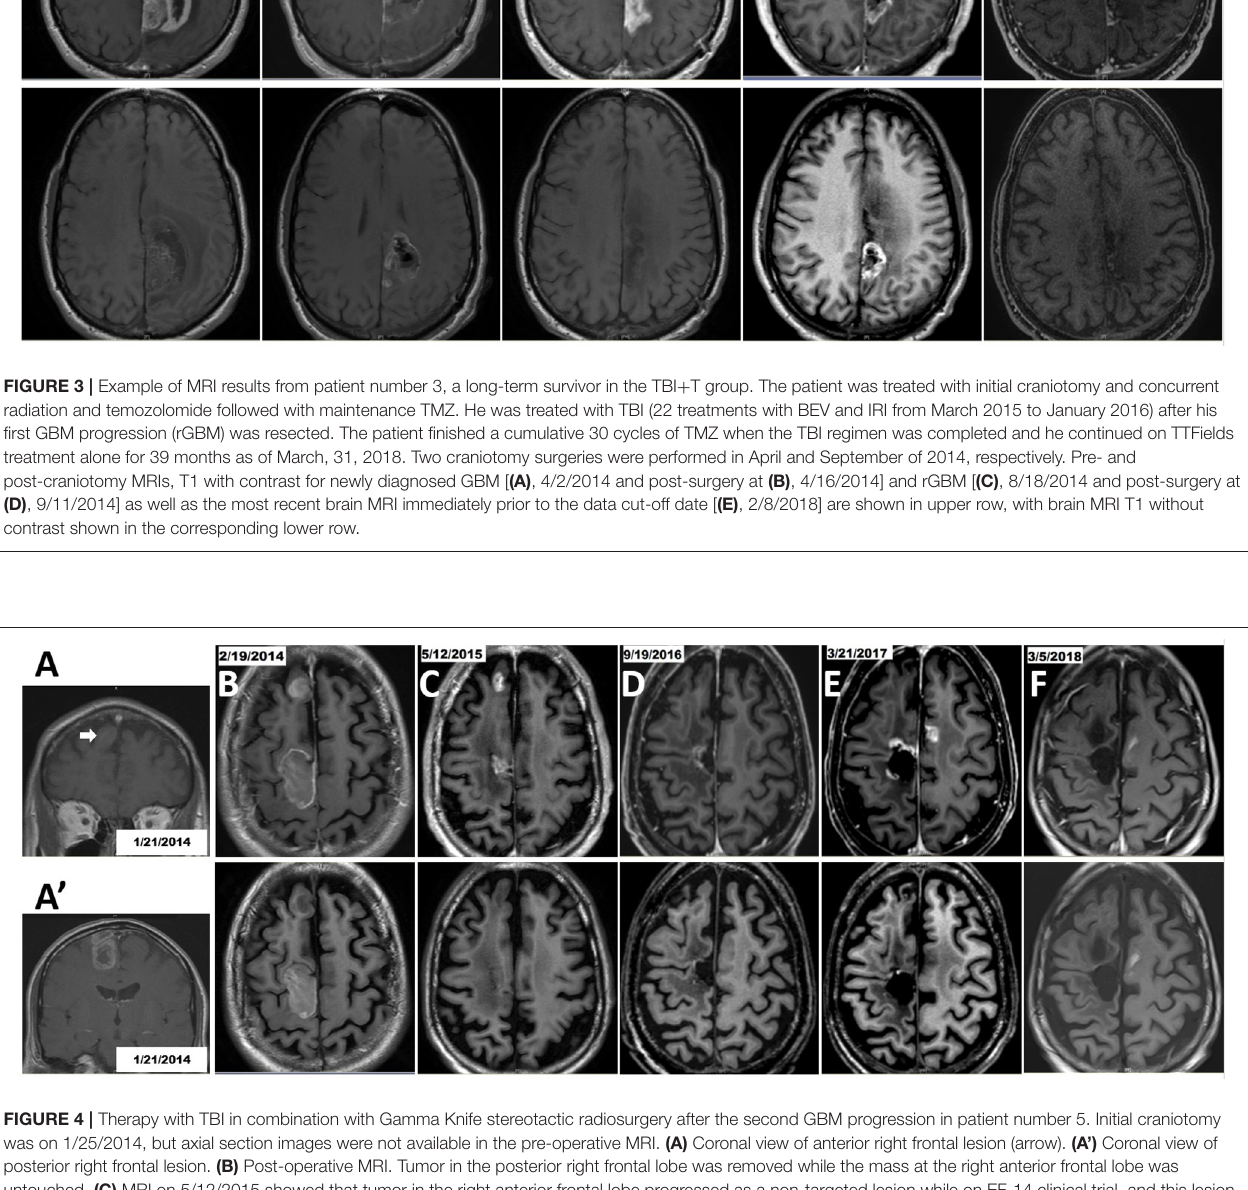
Frontiers in Neurology |